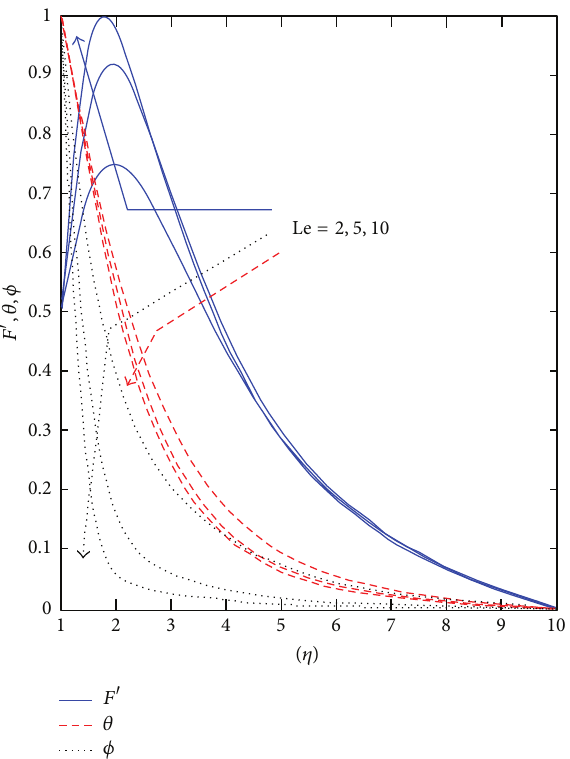
Figure 3: Plots of dimensionless similarity functions 𝐹 󸀠 (𝜂) , 𝜃(𝜂) , and 𝜙(𝜂) for various values of Le at Nr = 0.5, Nb = 0.5, Nt = 0.5, and 𝜁 = 1 .